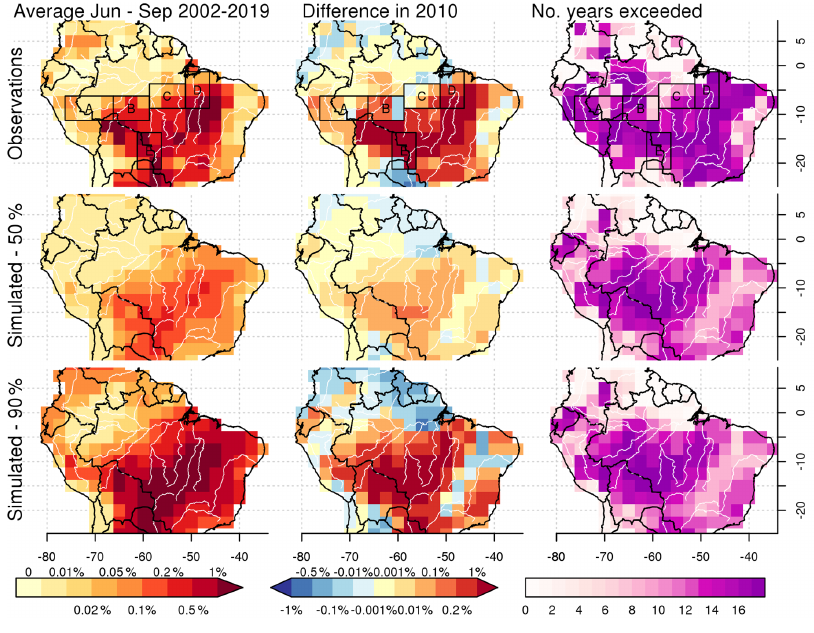
Figure C2. Same as Fig. C1 but for